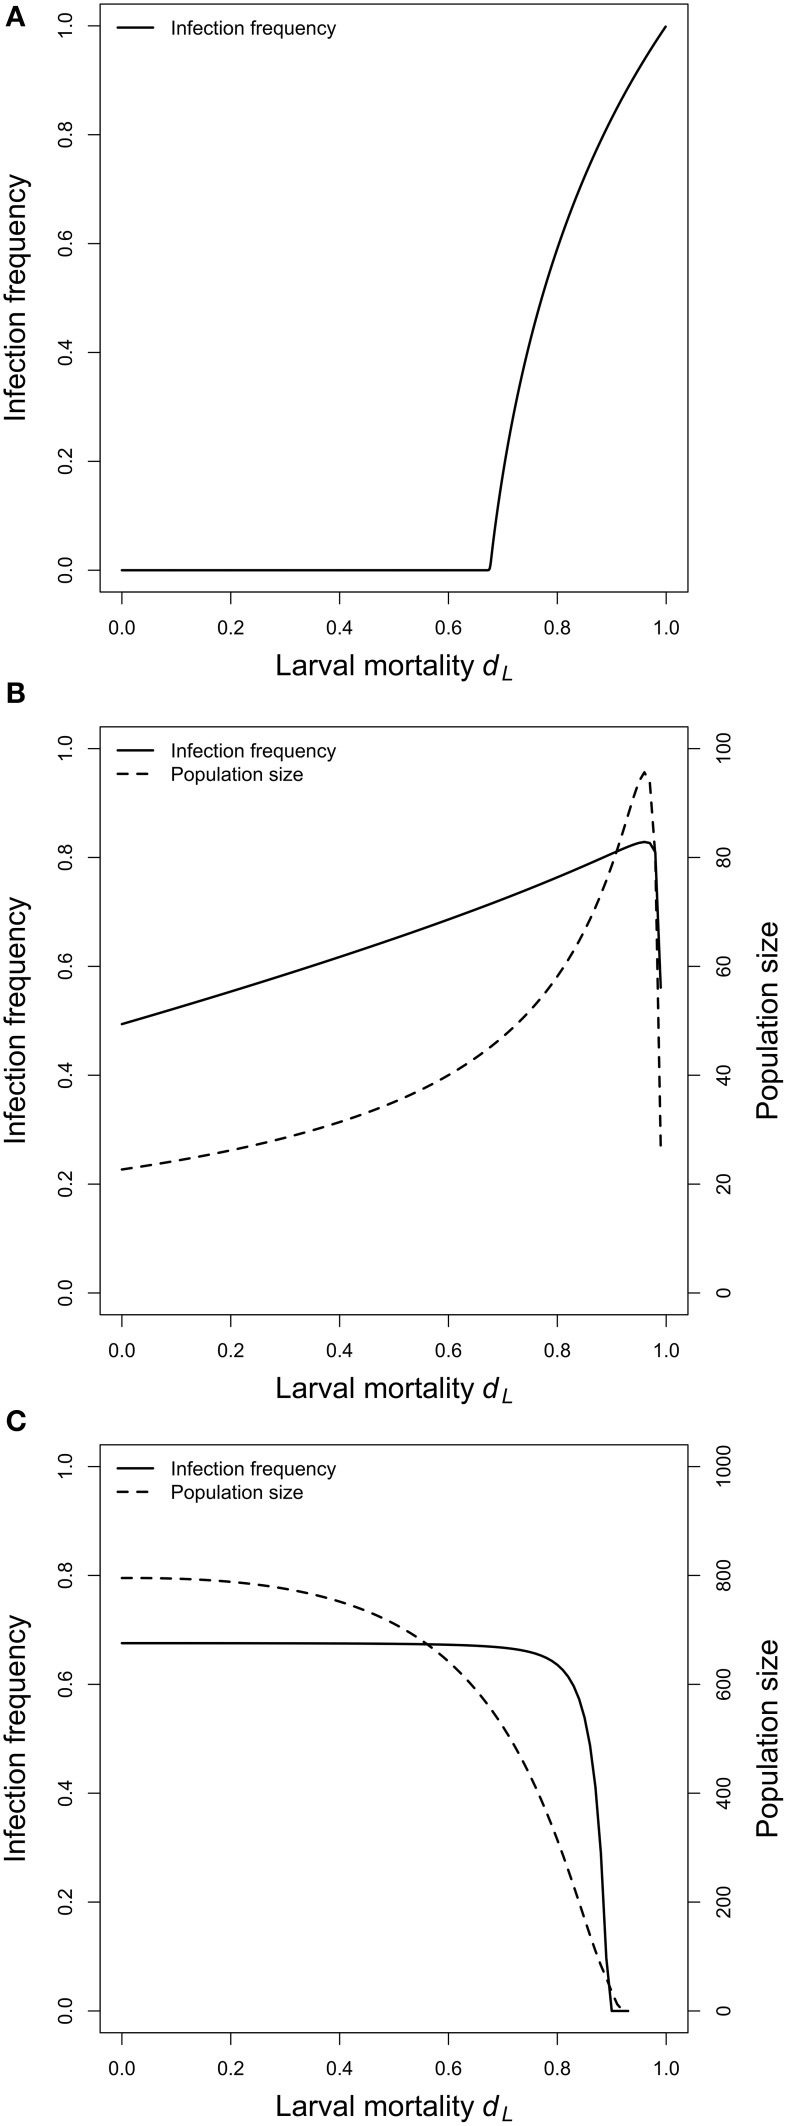
Virus equilibrium frequencies and equilibrium population sizes. (A) Adult competition model (ACM). Shown is the equilibrium frequency of the virus as a function of the larval mortality dL. There is a threshold value of dL, below which the virus cannot persist in the population. Above this critical value, virus frequencies increase with increasing larval mortality. (B) Larval competition model (LCM) with overcompensation. Shown are the equilibrium values of the infection frequency and the population size as a function of dL. The equilibria increase with increasing larval mortality, and reach maximum values at dL = 0.96. Larger dL results in a sharp decline of both values. (C) LCM with undercompensation. Infection frequencies and adult population sizes decrease with increasing larval competition. (B,C) show that the adult population size is the main determinant of the infection frequencies. Parameters: see Figure 2.